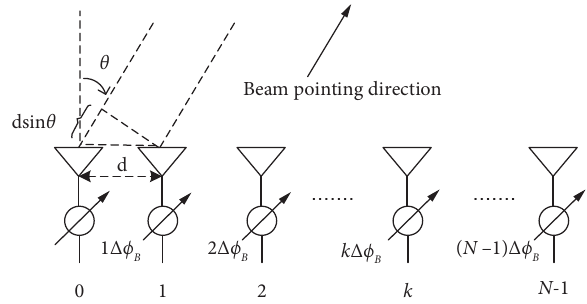
Figure 1: Schematic diagram of phased array antenna beamforming.